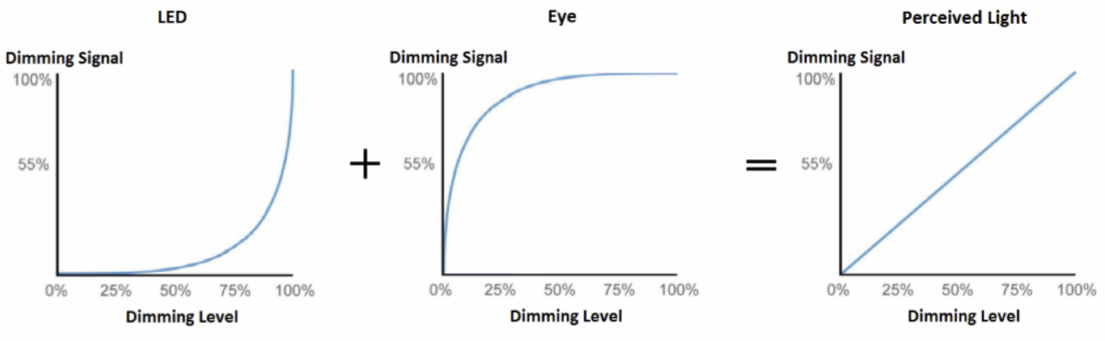
Figure 1. The right dimming curve of LED light sources (exponential) to have a linear perception of the increase in light intensity starting from a logarithmic trend of the eye’s sensitivity; the Dimming Signal (blue) represents the increase of illuminance curve.